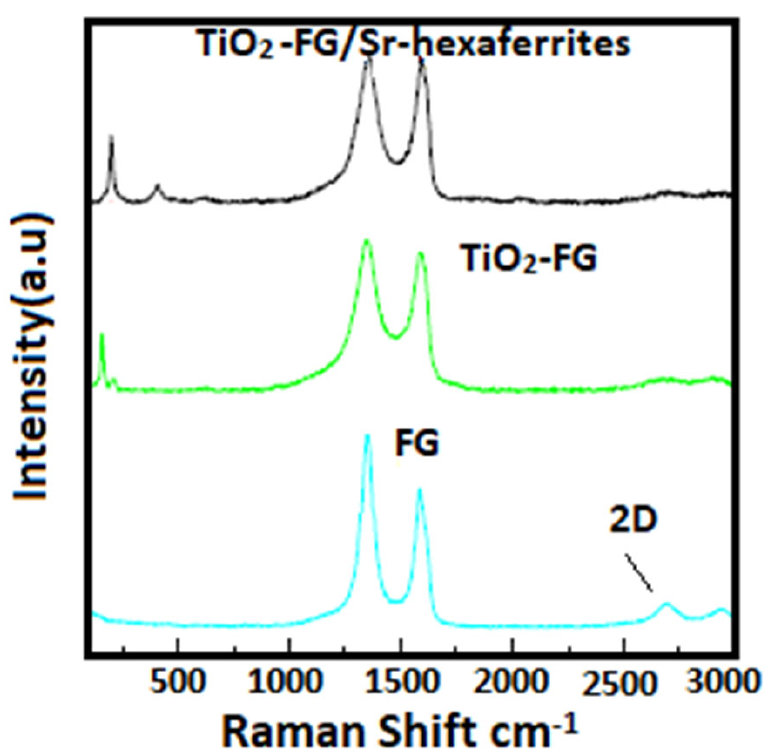
Figure 5. Raman spectrum of FG, TiO 2 -FG, and TiO 2 -FG/Sr-hexaferrites. The DRS spectra of the composites are shown in Figure 6. An evaluation of the absorption spectra of TiO 2 -GO and TiO 2 -FG is given in Figure 6 to check the absorption edge of the composites. It is clear that the functionalization greatly affects the absorbance properties. There is an enhanced absorbance towards the visible region of the composites